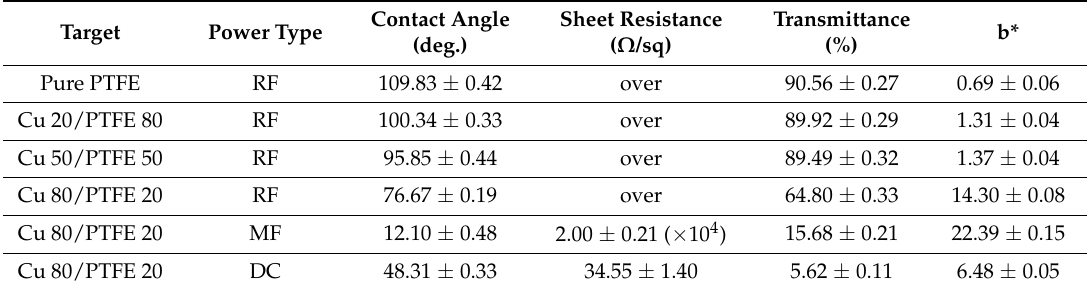
Figure 4. Optical transmittance at 500 nm for different Cu contents and power sources. Table 1. Properties of Cu/PPFC nanocomposite thin films using Cu/PTFE composite targets. b* — yellow index.